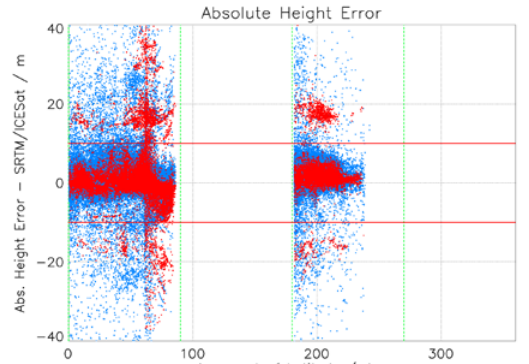
Figure 4. Absolute height error of TanDEM-X Raw DEMs compared to SRTM/ICESat for first (blue) and second (red)